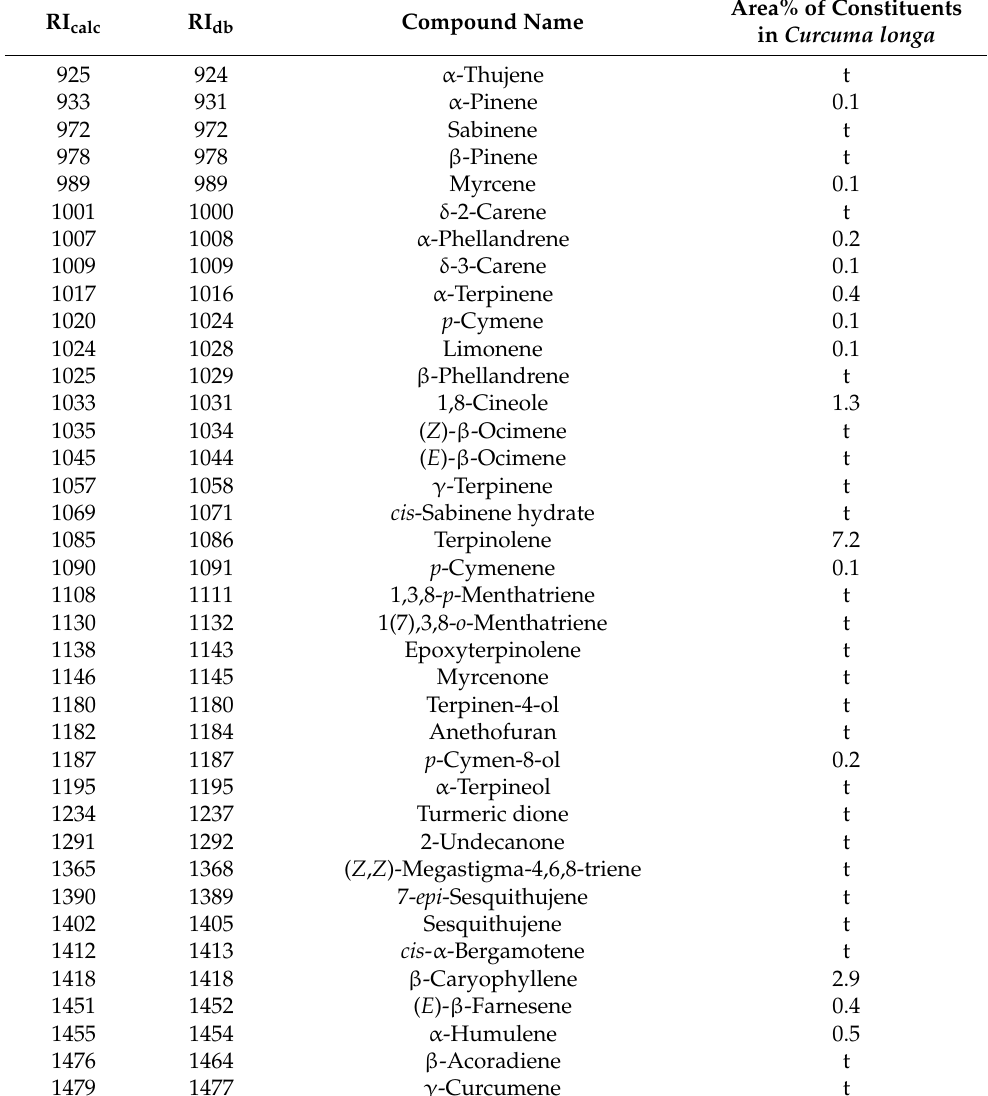
Table 1. Individual constituents of Curcuma longa essential